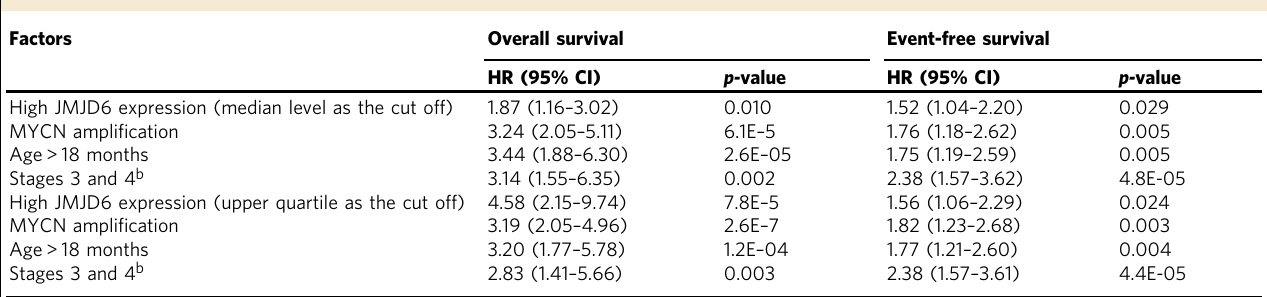
Table 1 Multivariable Cox regression analysis of factors prognostic for patient survival a Factors Overall survival Event-free